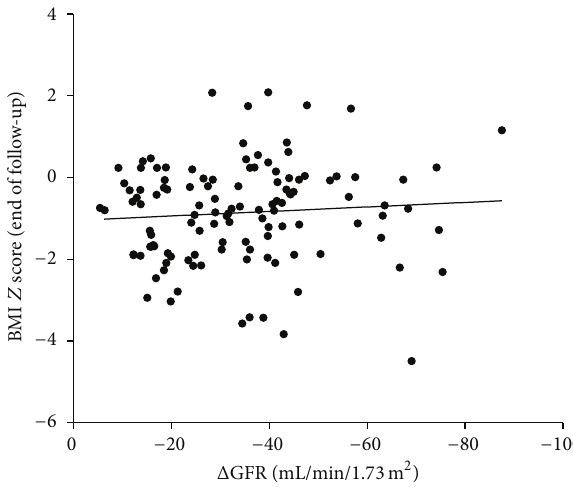
Figure 4: The absence of correlation between the decline of glomerular filtration rate ( Δ GFR) and the body mass index (BMI) 𝑍 score at last follow-up visit (end of follow-up) ( 𝑟 = −0.078 , 𝑃 = 0.40 ).